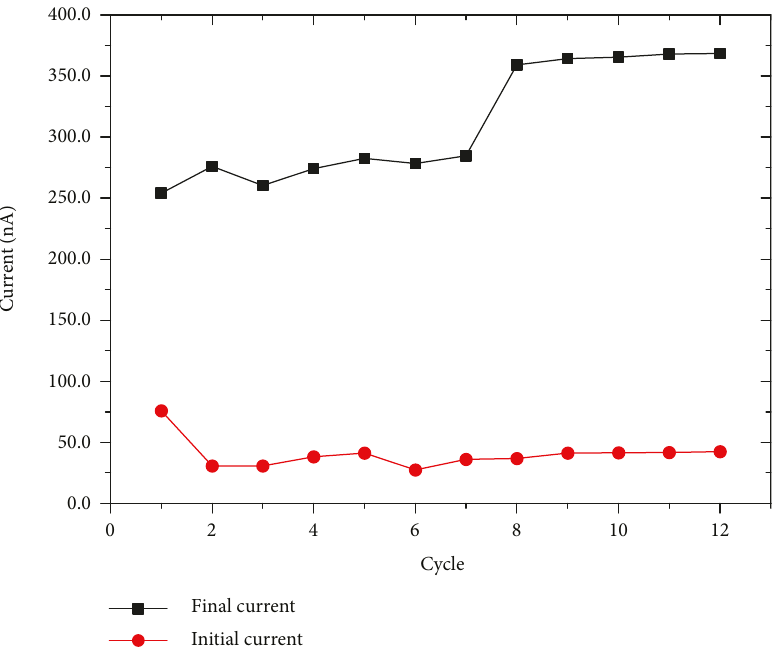
Figure 2: Demonstration of the LTP mechanism in the organic memristive devices: fi nal and initial current value per number of the given pulse.